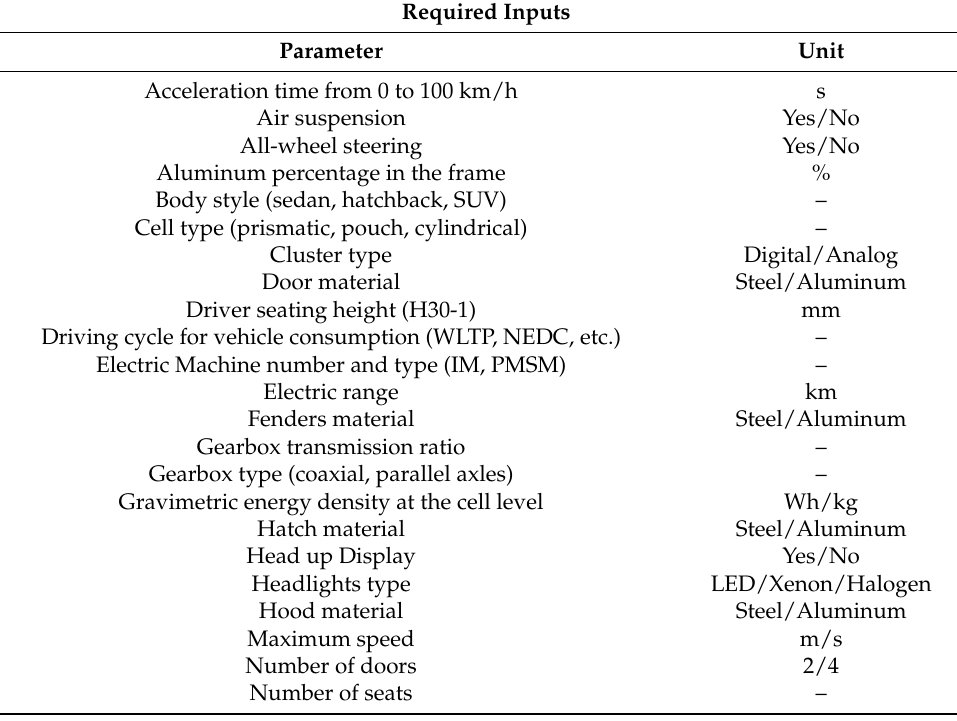
Table A1. Required Inputs for the vehicle architecture